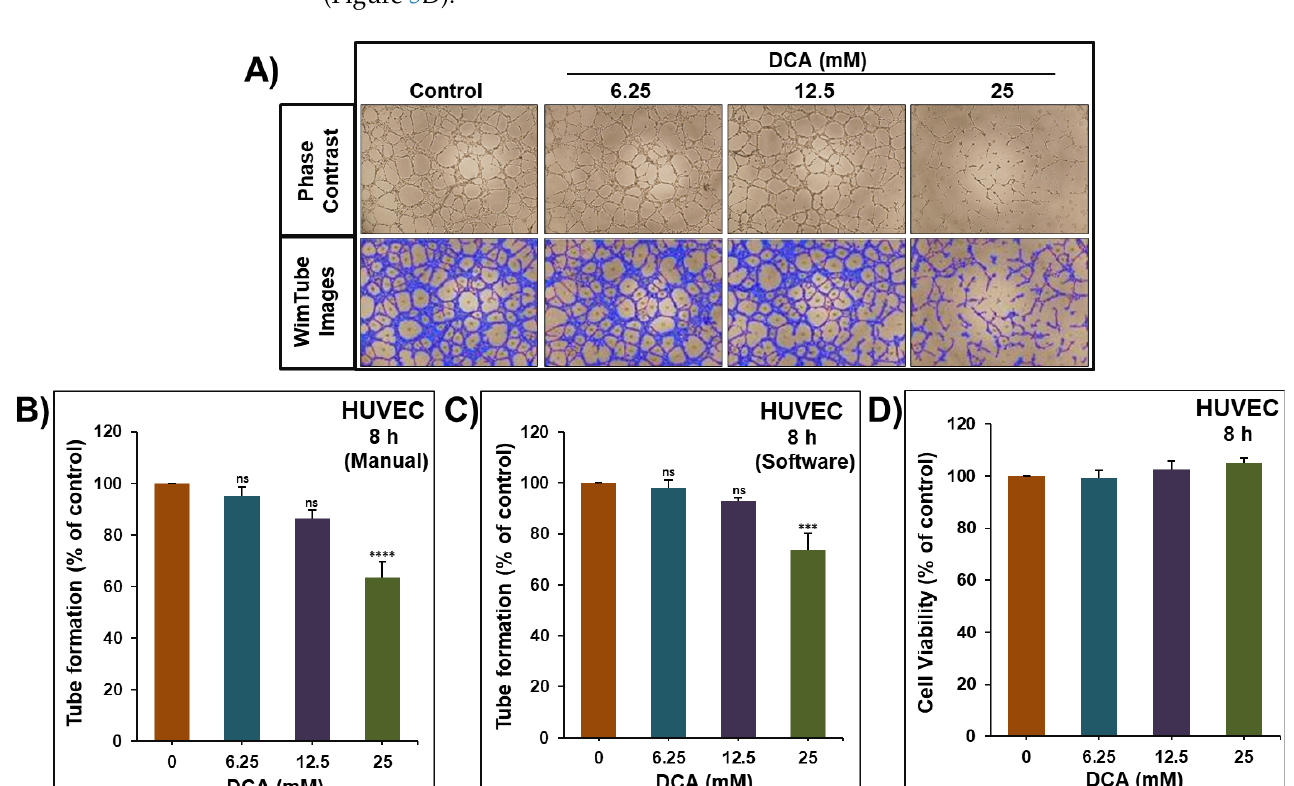
Figure 5. Effect of DCA on the formation of capillary-like structures by HUVECs in vitro. ( A ) Forms of angiogenesis induced in HUVEC cultured on Matrigel matrix in 96-well plate in the absence and presence of different concentrations of DCA. An inverted microscope (4 × ) was used for contrast photo and Wimasis software was used to clarify the pictures. ( B , C ) Quantification of tubular angiogenesis induced in HUVEC cells cultured in the absence and presence of DCA (6.25–25 mM) manually and by using Wimasis software, respectively. ( D ) HUVEC cells’ viability was determined as described in the Material and Methods in the absence and presence of DCA (6.25–25 mM). Experiments were repeated at least 3 times. Columns represent means; bars represent S.E.M. *** Significantly different at <0.001. **** Significantly different at <0.0001. ns—non-significant.